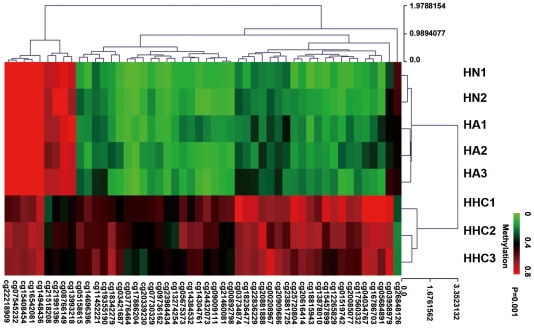
Heat map of methylated gene in the Illumina Infinium methylation assay.Heat map of 64 CpG locus were different methylated in 3 pairs of hepatocyte from HBHC(HHC) and adjacent liver(HA) with 2 normal liver(HN) as control(p<0.001). The hypermethylated and hypomethylated genes were indicated by red and green respectively. Unsupervised hierarchical cluster analysis represents a significent distinguishing HHCs from HAs and HNs. The Euclidean distance between two groups of samples is calculated by the average linkage measure between members of the two groups concerned.